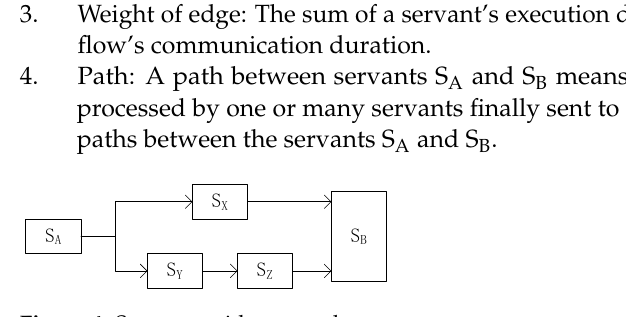
Figure 4. Servants with two paths.